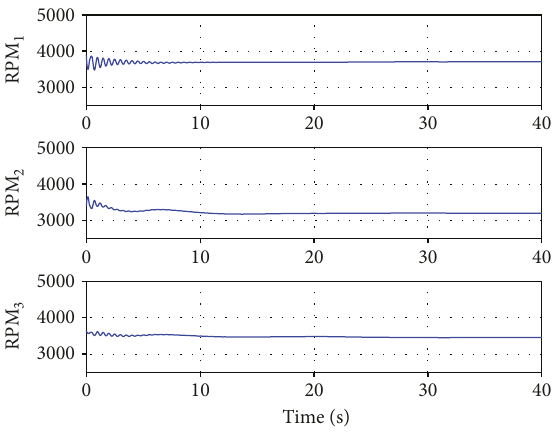
Figure 11: Weight value of the neural network in scenario 1.